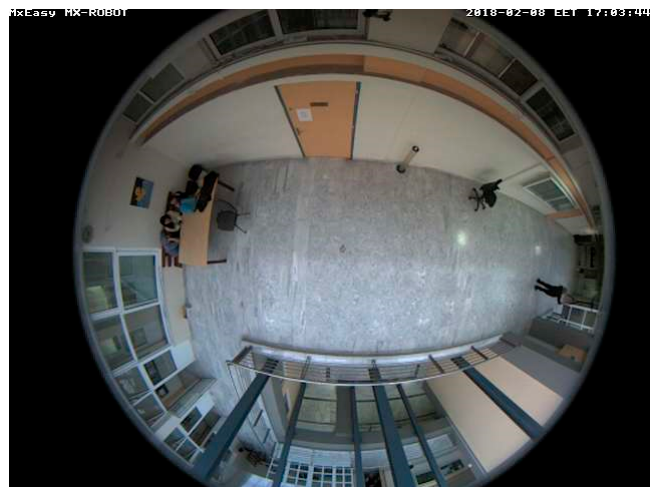
Figure 1. A typical image from a roof-based fisheye camera.